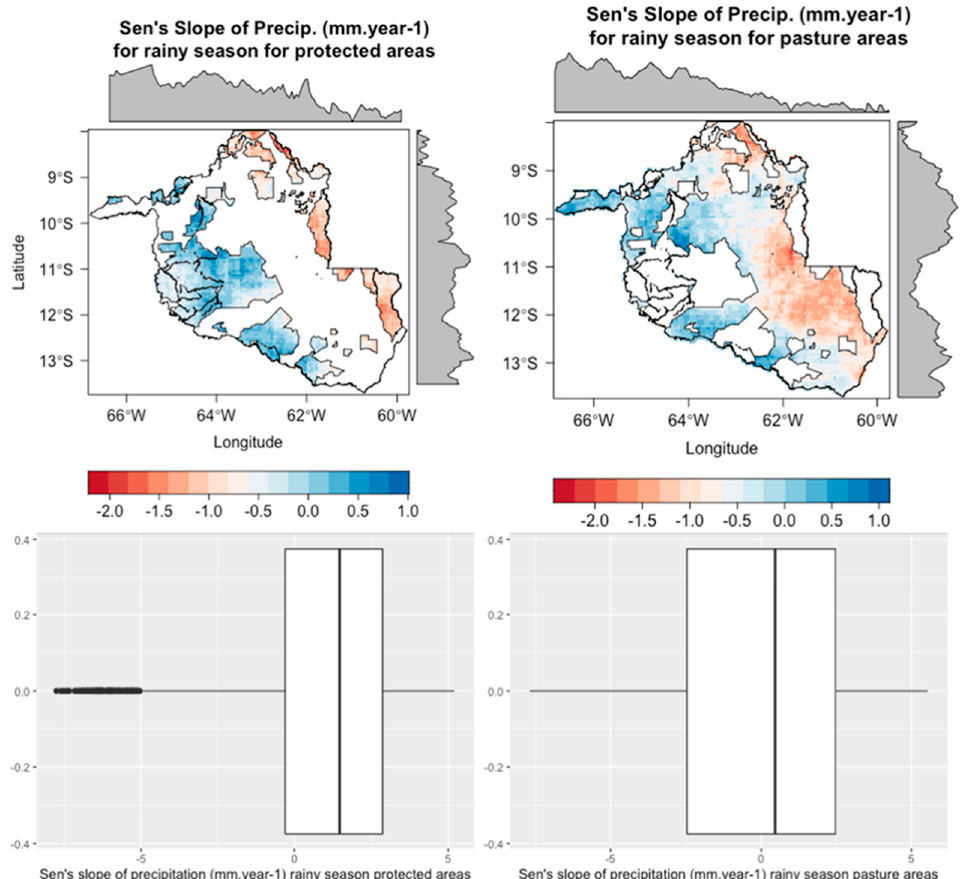
Figure 10. Spatialization of the Sen’s Slope for rainfall for the dry season in Rondônia for the years 1981 to 2020 using CHIRPS data for protected and pasture areas.